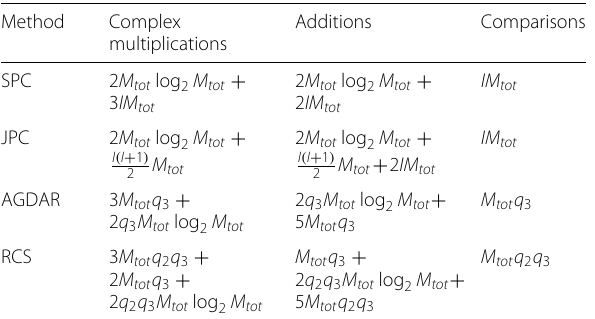
Table 1 Computational complexity of the channel estimation